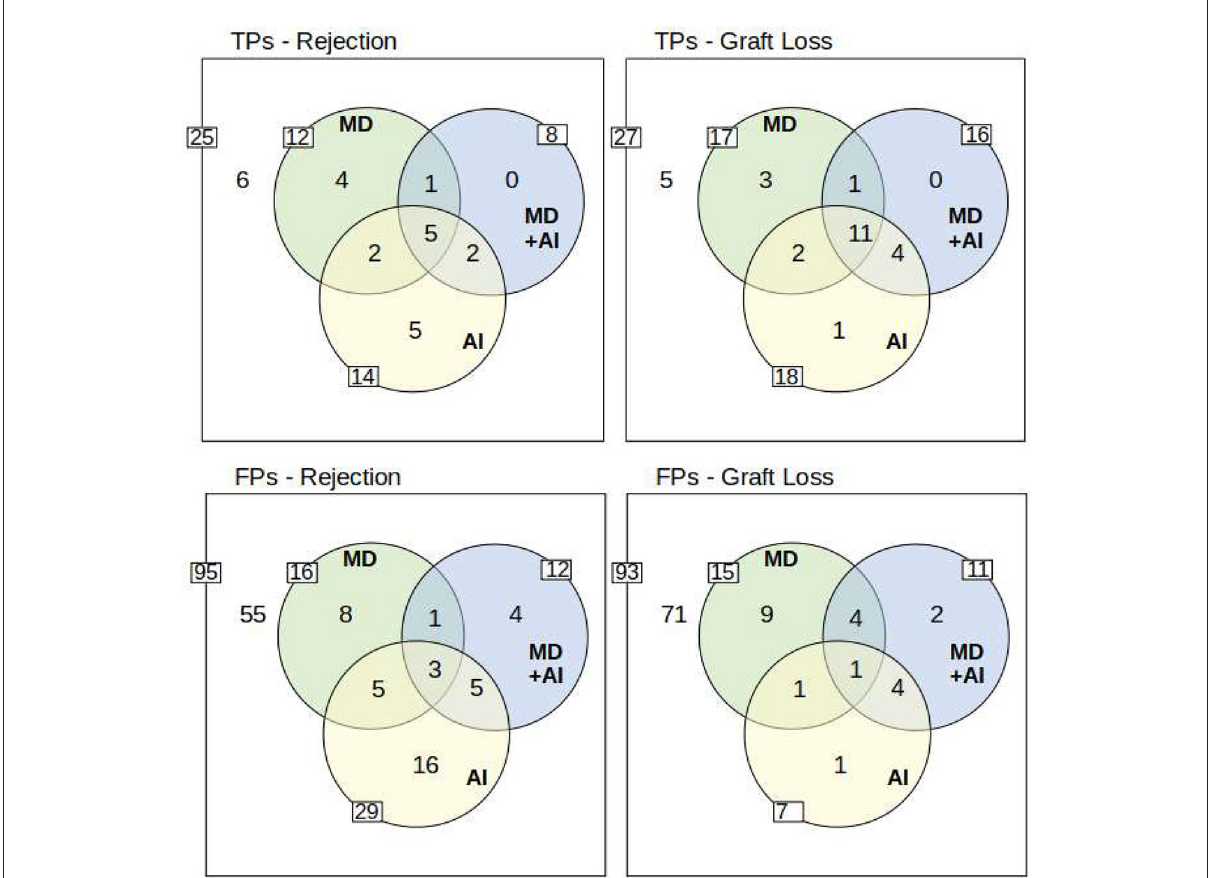
FIGURE4 Overview of True Positives (TP) and False Positives (FP). The outer white rim describes the number of positives/negatives for each endpoint. The inner side of each circle indicates the number of true/false positives of AI, MD, and MD + AI. Moreover, the overlapping circles show the overlaps of true/false positive predictions between the different participants. The yellow circle of the AI system represents data points which were flagged with a yellow or red traffic light in the dashboard. To understand the example, take for instance TPs-Rejection: Overall 25 rejections (25 positives of 120 data points) occurred, from which 6 have not been detected by anyone in the study. AI predicted 14 (5 + 2 + 5 + 2) correctly, while MD predicted 12 (4 + 1 + 5 + 2), and MD + AI predicted 8 (1 + 5 + 2) correctly. Five TPs are predicted by all (see intersection of all three circles). Moreover, two TPs are predicted only by MD and AI, and two other TPs only by MD + AI and AI. Only one TP is identified by MD and MD + AI. Finally, 4 TPs are predicted correctly only by MD, and 5 other TPs only by AI. MD + AI does not predict any additional TP which is already found by MD or AI. The lower row presents the same scenario for falsely predicted data points. A more detailed overview including also the results for the red and yellow warning of the traffic light system is included in the Supplementary